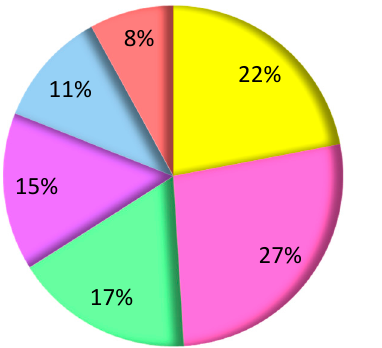
Figure 8. Comparison of identification results.